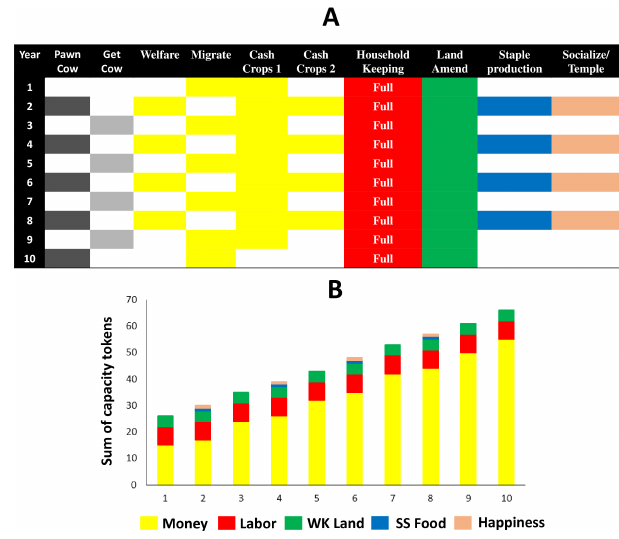
Fig. 9. (A) Simulation of a single-family game using a playing strategy that results in an outcome in the upper limit of the solution space in The Flow of Peasant Lives. Dice outcomes are assumed to favor the household team in every round. As with the strategy addressed in Fig. 7A, this strategy uses a full level of labor. However, this household team also pawns their cow (savings) and balances a pluriactivity monetary economy with household-keeping. (B) Dynamics of rapid capacity reproduction resulting from the strategy shown in (A). The horizontal axis shows the sequence of